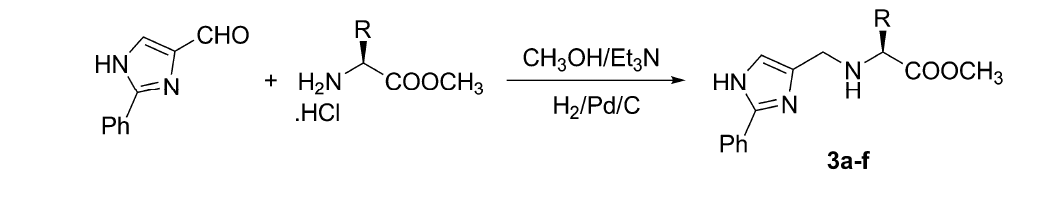
Table 1. Bidentate ligands 3a-f